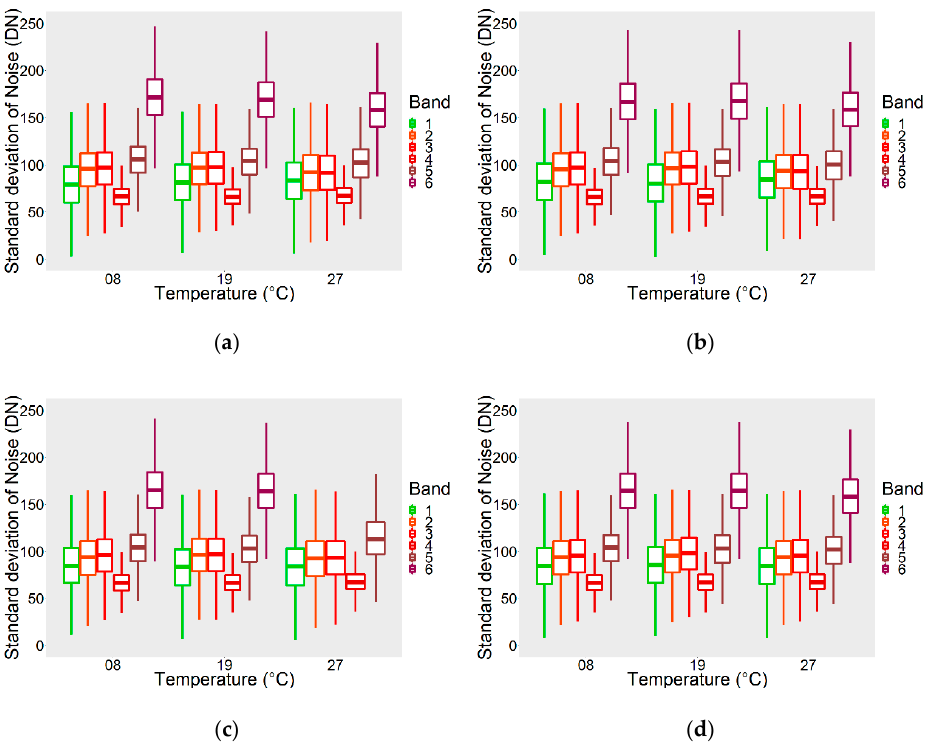
Figure 12. Comparison of the per-pixel SD noise characteristics divided by exposure time: ( a ) Exposure time 50 µ S; ( b ) Exposure time 250 µ S; ( c ) Exposure time 500 µ S; ( d ) Exposure time 1000 µ S.